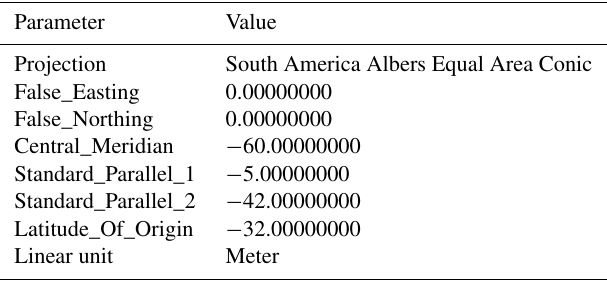
Table 1. Parameter configuration of projection used for all calcula- tions of area and length in this